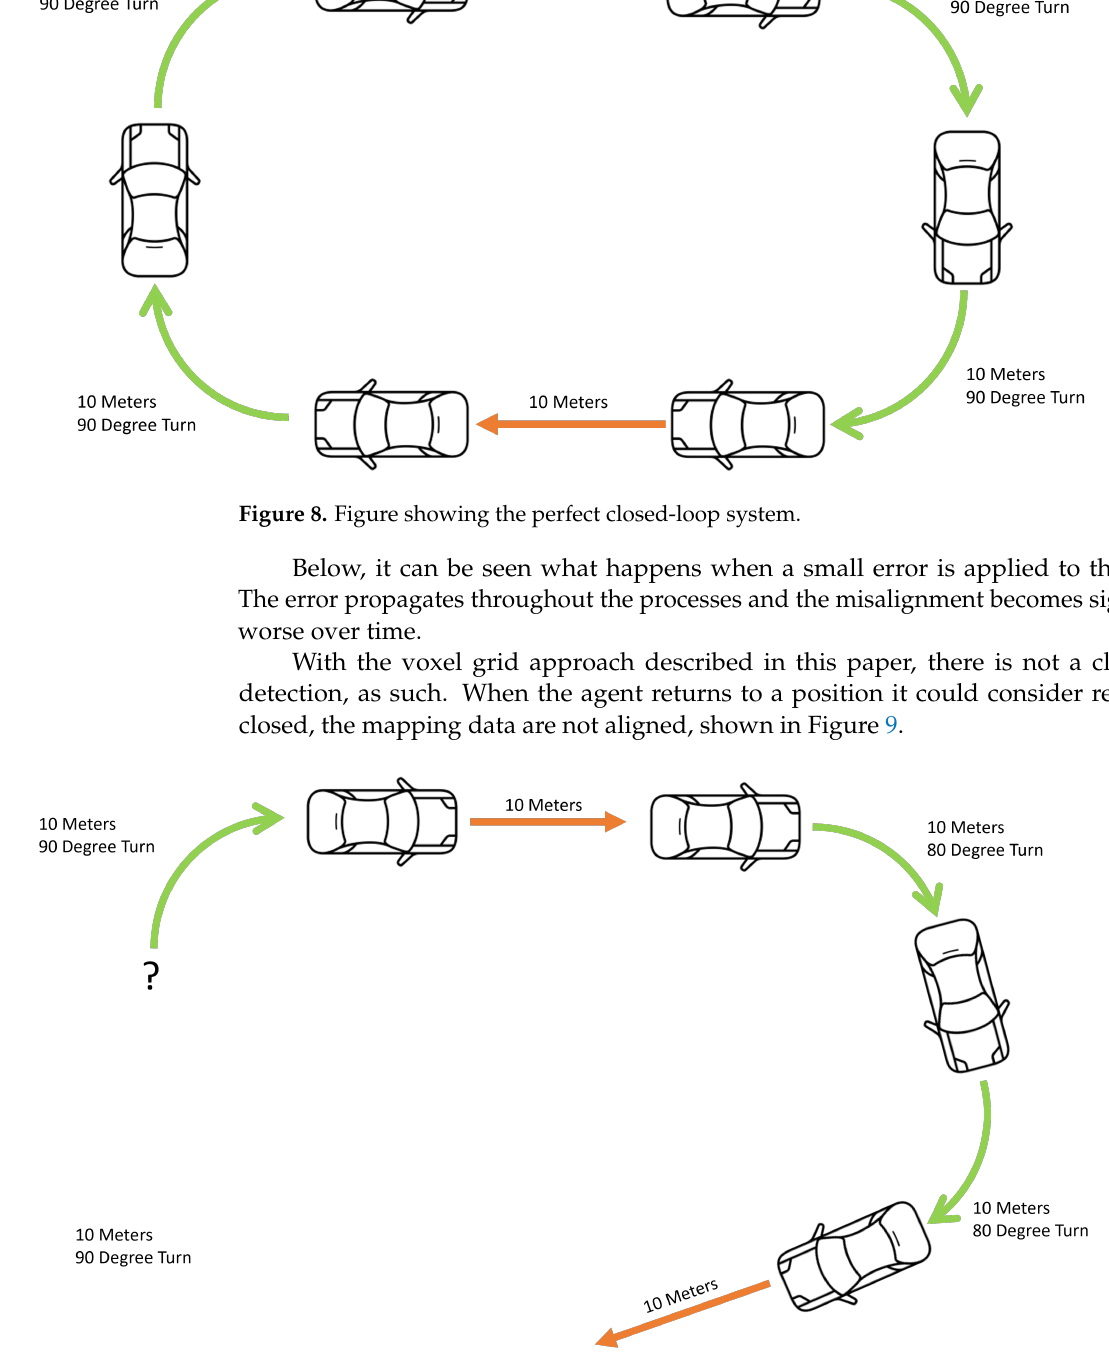
Figure 9. Figure showing the imperfect closed-loop